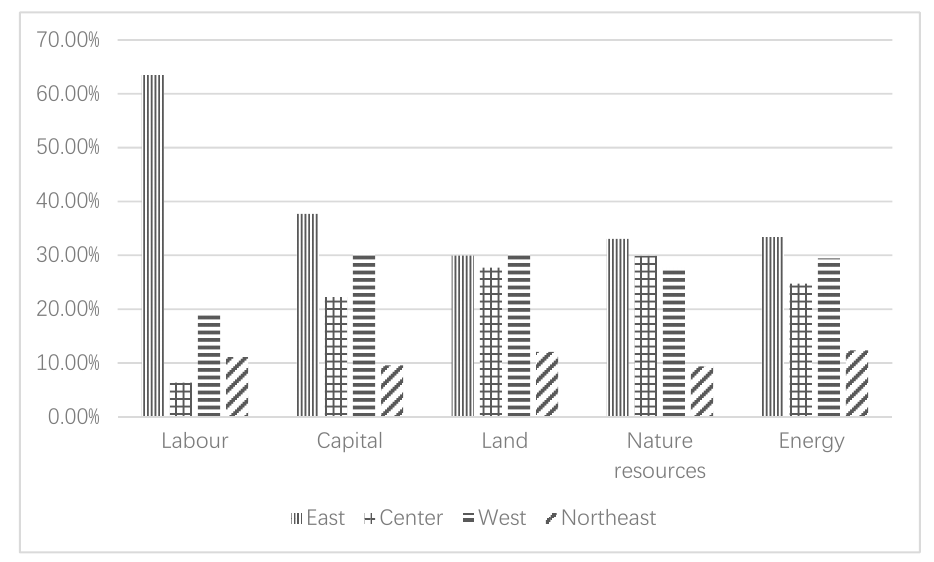
Figure 5. Input redundancy of DMUs.